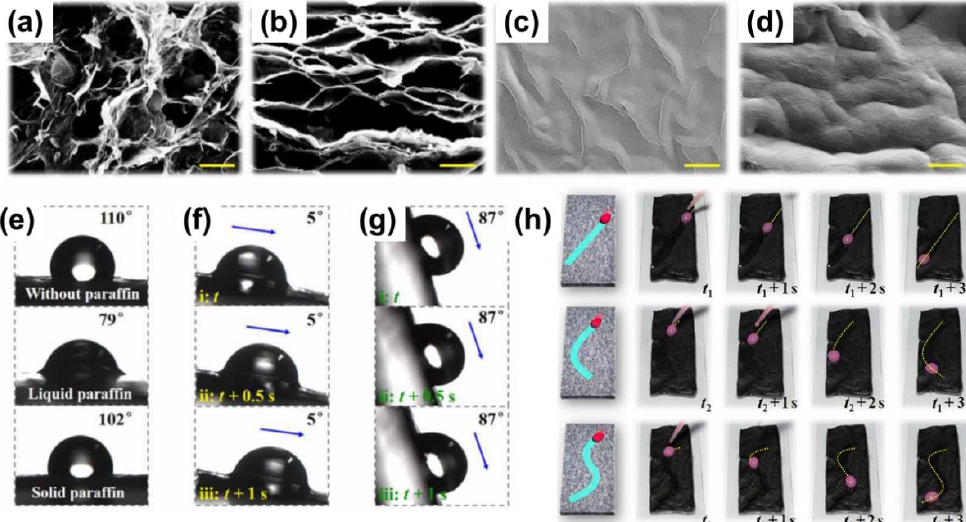
Figure 6. SEM ( a ) and cross-section ( b ) of a graphene sponge film; SEM ( c ) and cross-section ( d ) of a paraffin-infused graphene film. ( e ) Water contact angles of the porous graphene sponge film, the paraffin-infused graphene film in the presence and absence of radiation, respectively. ( f ) Demonstration of the droplet sliding on the paraffin-infused graphene film under the radiation of laser. ( g ) Demonstration of the droplet sliding on the paraffin-infused porous graphene film in the absence of the radiation. ( h ) Demonstration of the droplet sliding on a predefined route. The scale bar is 10 µ m. From [43]. Reprinted with permission from AAAS.